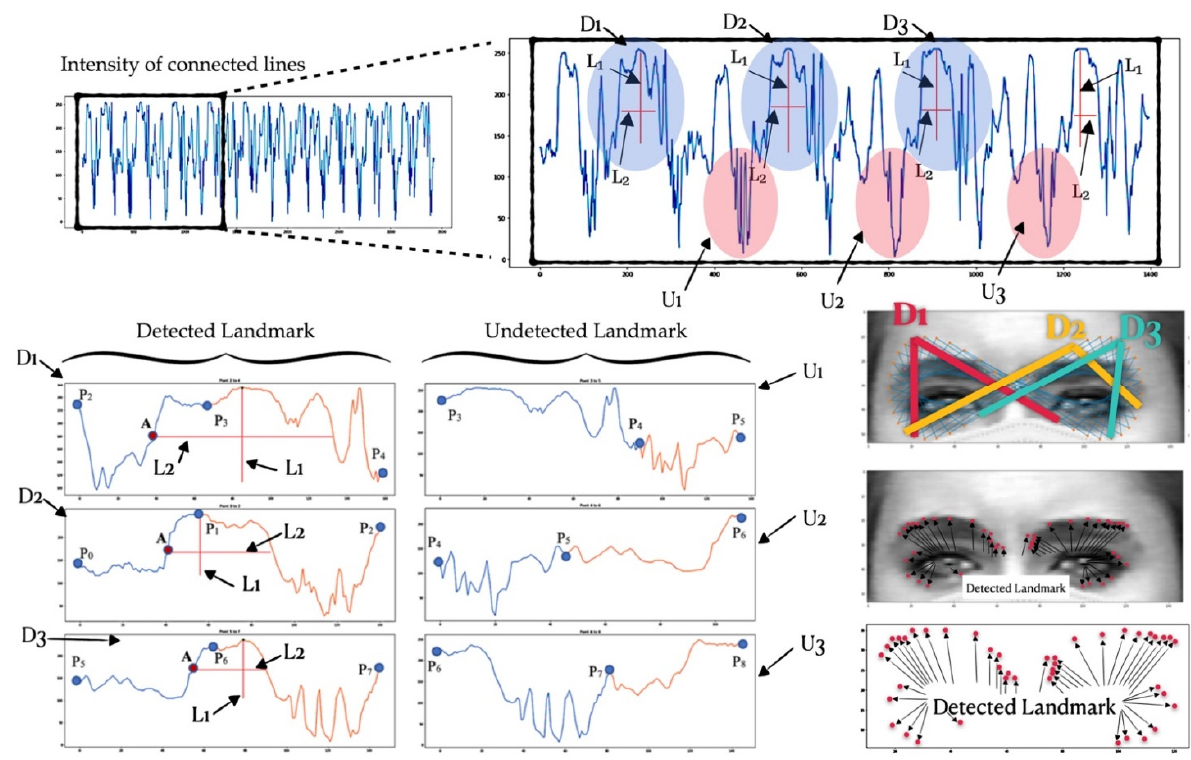
Figure 10. Detected and undetected